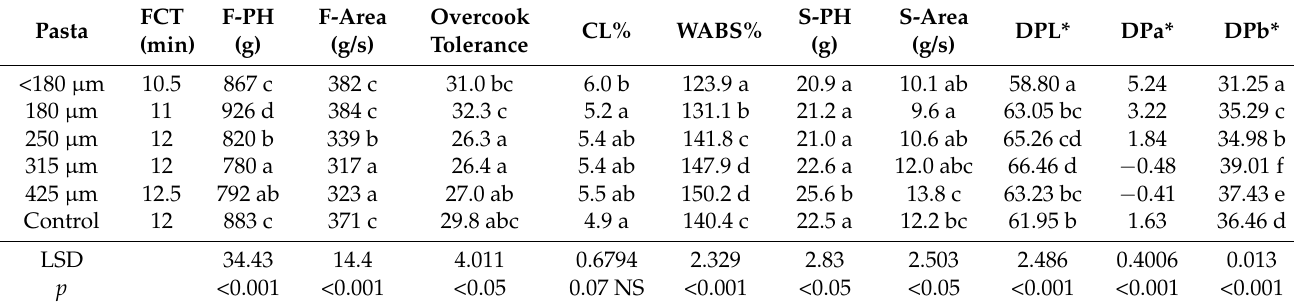
Table 2. Pasta made from the different semolina fractions and the effect on pasta technological